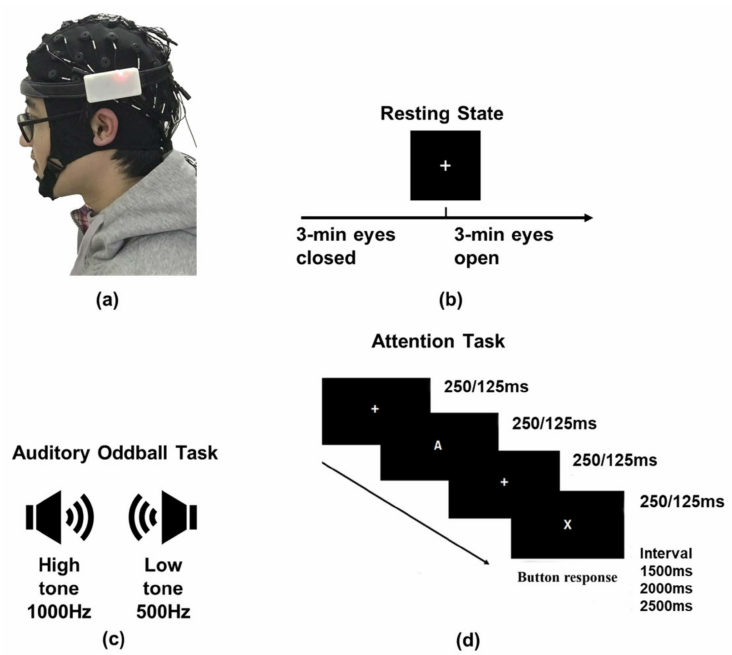
Figure 3. Signal quality comparison experiments. ( a ) Wearing position of Neuroscan and Mindeep; ( b ) resting state task; ( c ) auditory oddball task; and ( d ) two kinds of AX-CPT tasks (AX-CPT-250 ms and AX-CPT-125